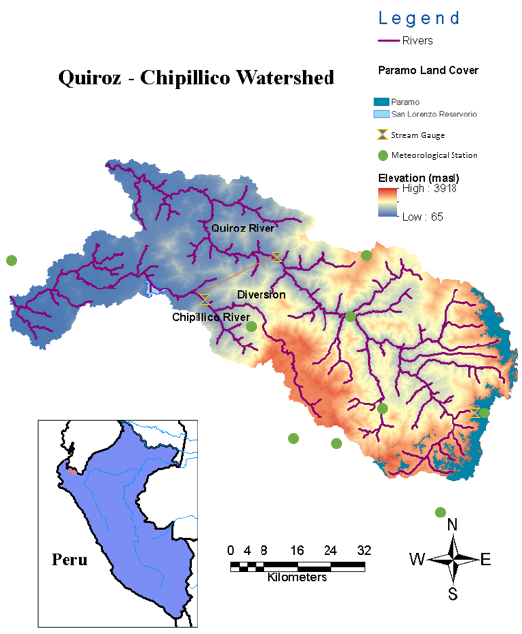
Figure 1. Location of Quiroz-Chipillico watershed in Piura, Peru.